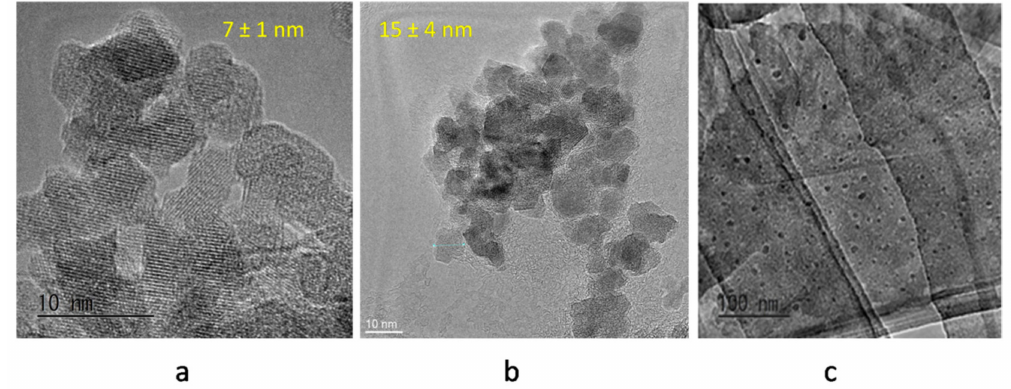
Figure 10. Fe 3 O 4 nanoparticles synthesized by ascorbic acid mediated reduction of Fe(acac) 3 , ( a ) without water, ( b ) with water, ( c ) graphene–Fe 3 O 4 nanoparticles